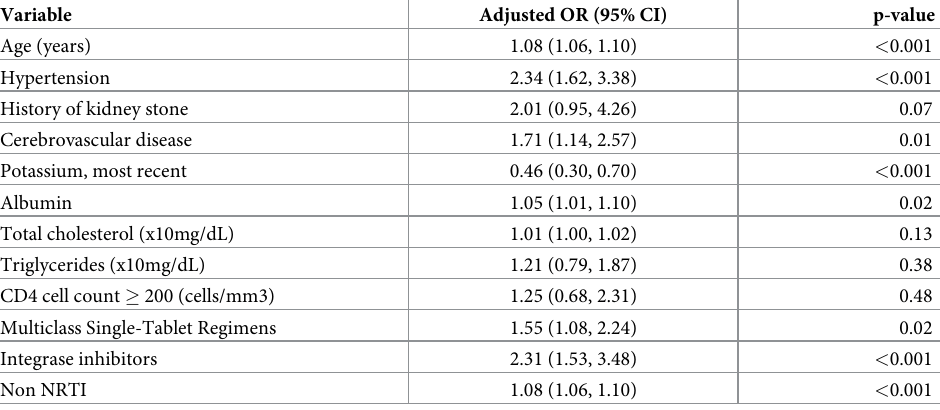
Table 2. Characteristics associated with CKD, multiple logistic